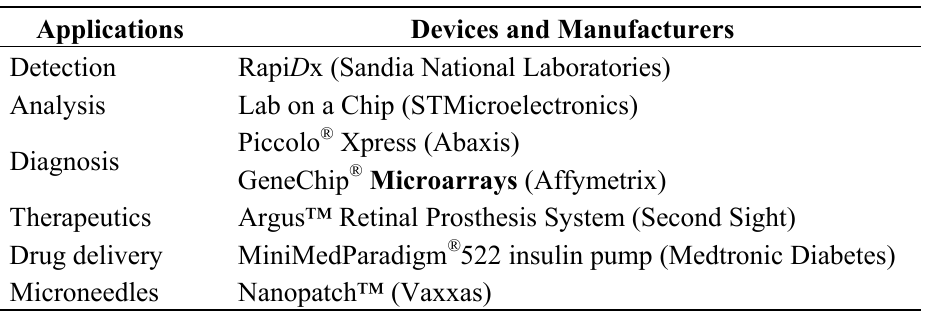
Table 3. Applications of